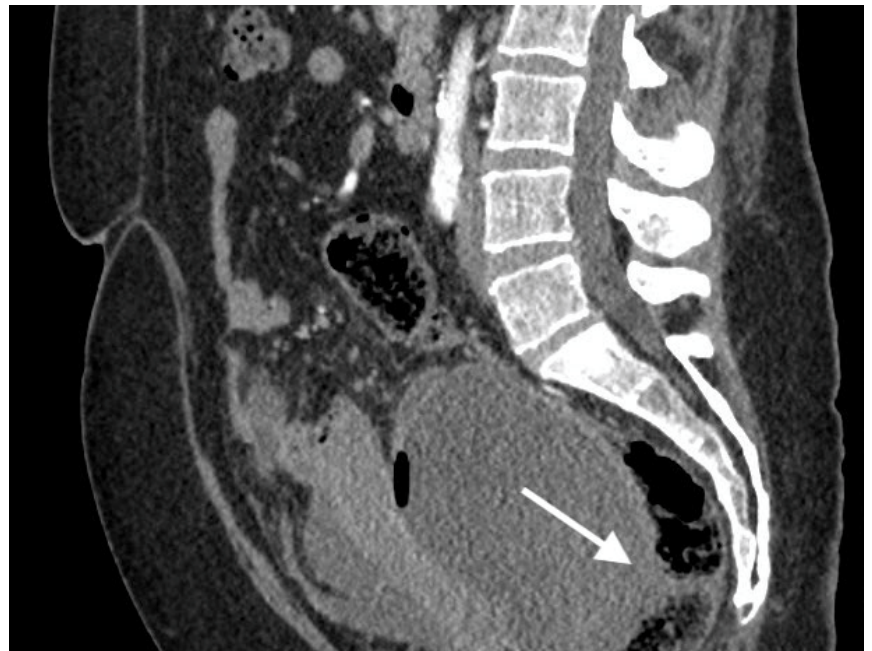
Figure 3. Images of a 57-year-old patient with high-grade serous ovarian cancer recurrence. Com- puted tomography shows large cystic-solid pelvic tumor with fluid/gas level and adjacent rectum as indirect sign of fistula.